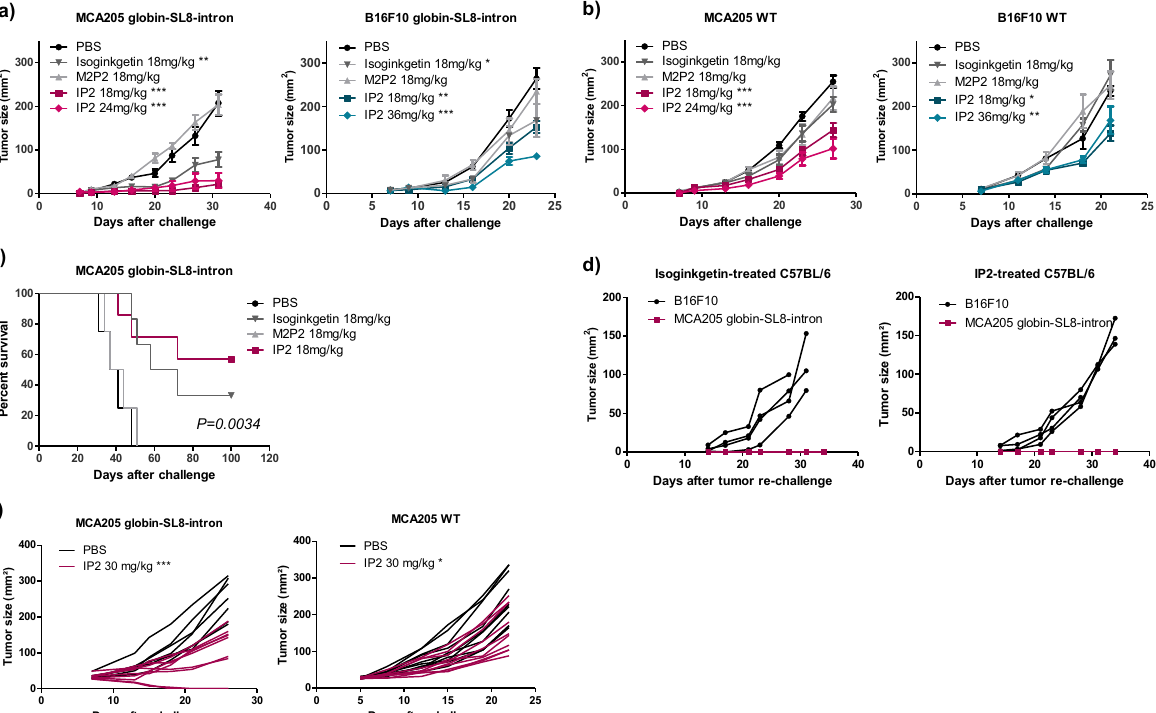
Fig. 3 IP2 treatment reduces tumor growth and extends survival. Tumor growth kinetics of ( a ) MCA205 fi brosarcoma (left panel) and B16F10 melanoma (right panel) both stably expressing the globin-SL8-intron construct and ( b ) MCA205 fi brosarcoma WT (left panel) and B16F10 melanoma WT (right panel) subcutaneously inoculated into the right fl ank of immunocompetent C57BL/6 mice thereafter treated at days 5, 10, and 15 with isoginkgetin, M2P2, or IP2 at indicated doses. Data are means ± SEM of tumor sizes for 6 – 8 mice per group. c Kaplan – Meier survival curves of mice subcutaneously challenged with MCA205 fi brosarcoma cells stably expressing the globin-SL8-intron construct and thereafter treated intraperitoneally with 18 mg/kg of isoginkgetin, 18 mg/kg of M2P2 or 18 mg/kg of IP2. A Log-rank (Mantel – Cox) test was performed. d Individual tumor growth kinetics of MCA205 cells stably expressing the globin-SL8-intron construct and B16F10 WT cells inoculated at day 100 in the ipsilateral side and the contralateral side, respectively, of C57BL/6 mice which experienced total tumor regression after fi rst inoculation of MCA205-globin-SL8-intron at day 0 and subsequent treatment with isoginkgetin (left panel) or IP2 (right panel) at days 5, 10, and 15. e Individual tumor growth kinetics of MCA205 fi brosarcoma stably expressing the globin- SL8-intron construct (left panel) and MCA205 fi brosarcoma WT (right panel) subcutaneously inoculated into the right fl ank of immunocompetent C57BL/ 6 mice thereafter treated once established (30 mm²) at days 5, 10, and 15 with 30 mg/kg of IP2. * P < 0.05, ** P < 0.01, *** P < 0.001 (One-way ANOVA). COMMUNICATIONS BIOLOGY| (2021) 4:269